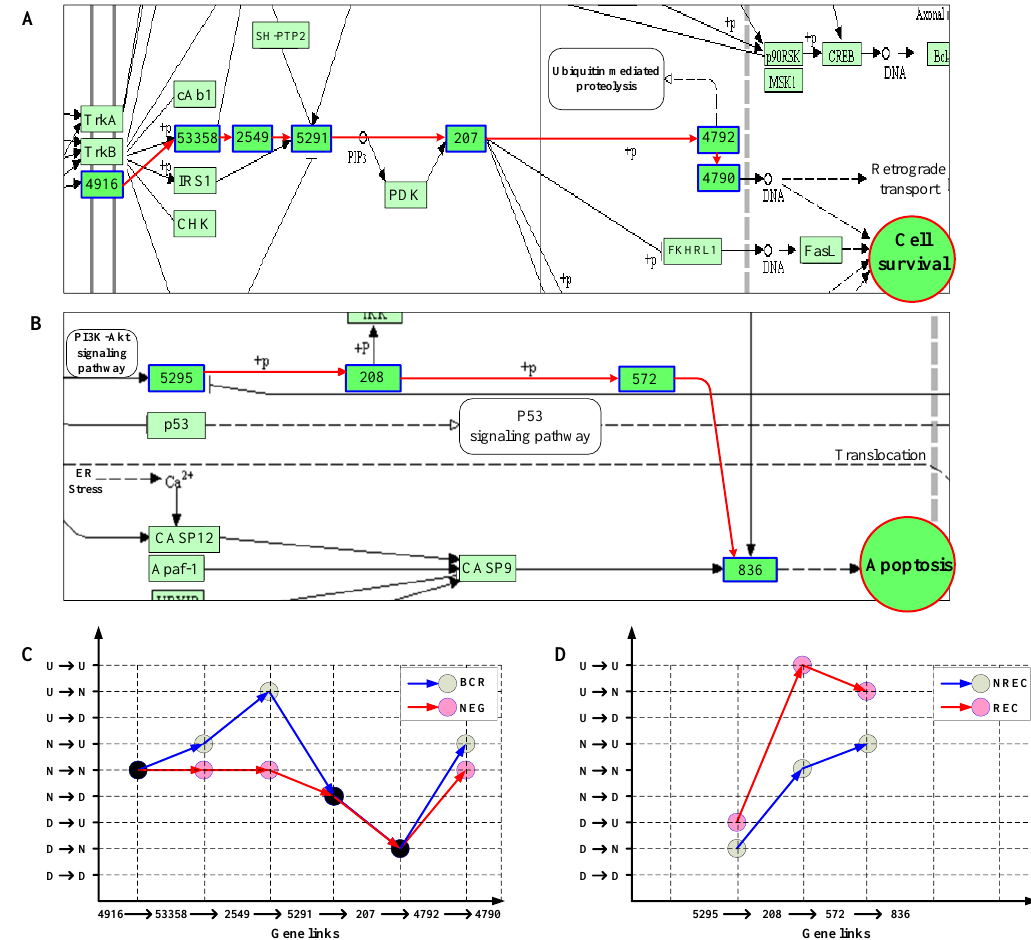
Figure 6. Key chains ( A , B ) and their principal patterns of state transitions ( C , D ) in two classes on the ALL ( A , C ) and liver ( B , D ) datasets. Genes involved are marked with blue-edge boxes and labeled with their Entrez IDs.